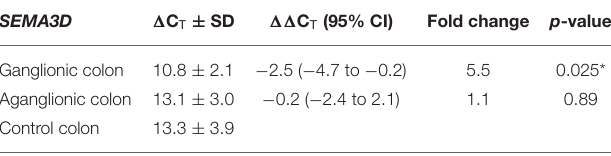
TABLE 4 | SEMA3D expressions in colon of HSCR patient and control. SEMA3D